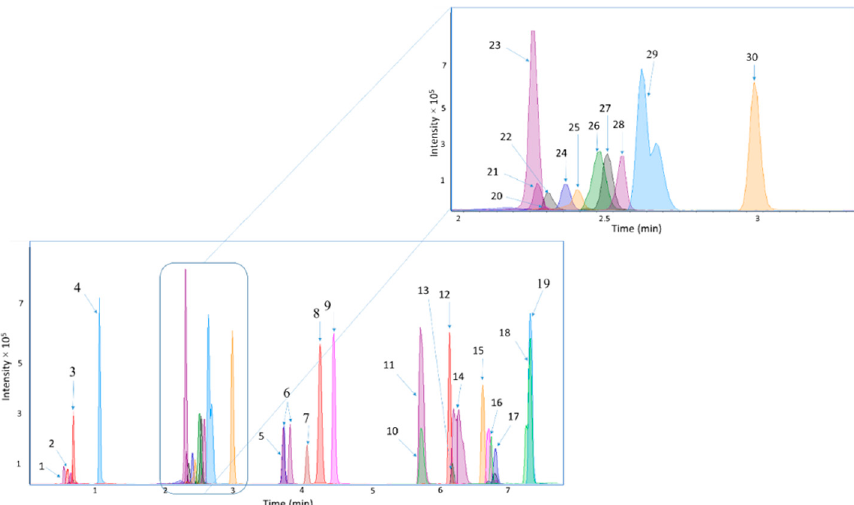
Figure 1. Chromatograms representing the chromatographic separation of the analytes. The peak numbers correspond to the following analytes: (1) Crea, (2) GBB, (3) β -OHB, (4) N-MNA, (4) Kynu, (6) Leu and Ile, (7) Phe, (8) AzelA, (9) Trp, (10) TUDCA, (11) TCA, (12) GCA, (13) GUDCA, (14) TDCA and TCDCA, (15) CA, (16) CDCA, (17) GCDCA and GDCA, (18) UDCA, (19) DCA, (20) Gly, (21) Gln, (22) ADMA and SDMA, (23) taurine, (24) Phe, (25) Gln, (26) HCit, (27) Ala, (28) AADA, (29) IndS and (30) Tyr.